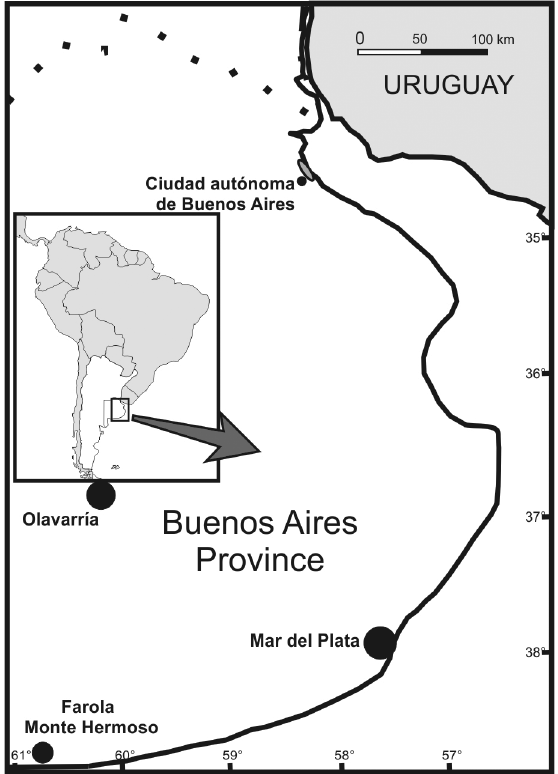
Figure 1 - Map showing Olavarría, Mar del Plata and Farola Monte Hermoso (Buenos Aires province,